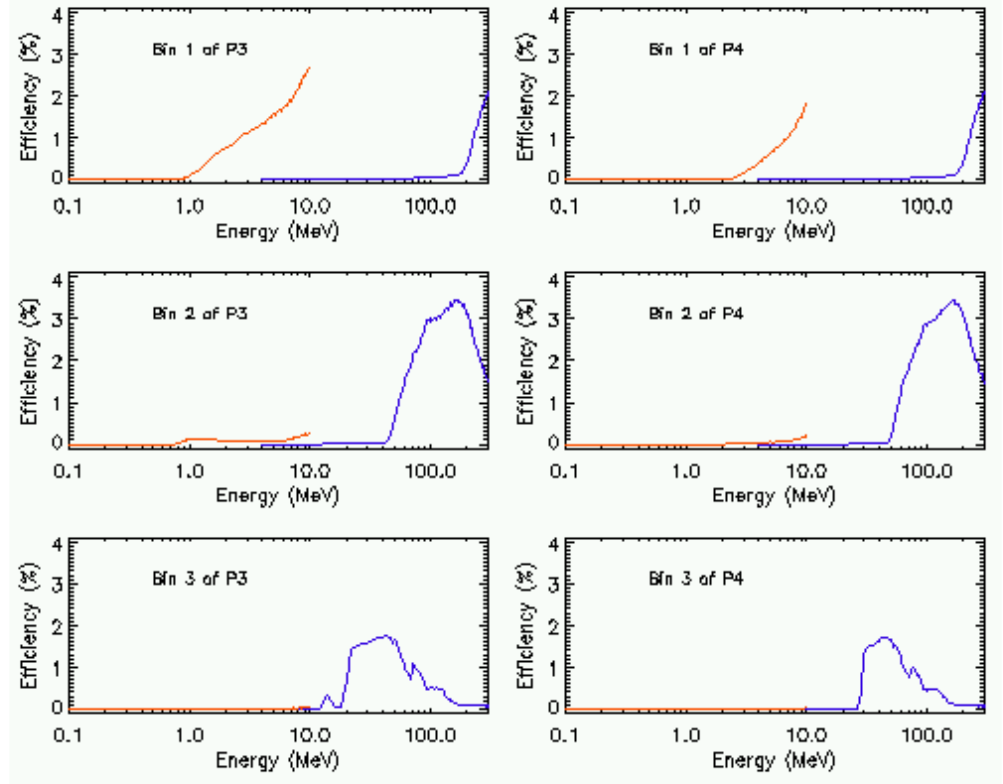
Fig. 1. Efficiencies of the CPD channels for electrons (red) and protons (blue) under the isotropic flux